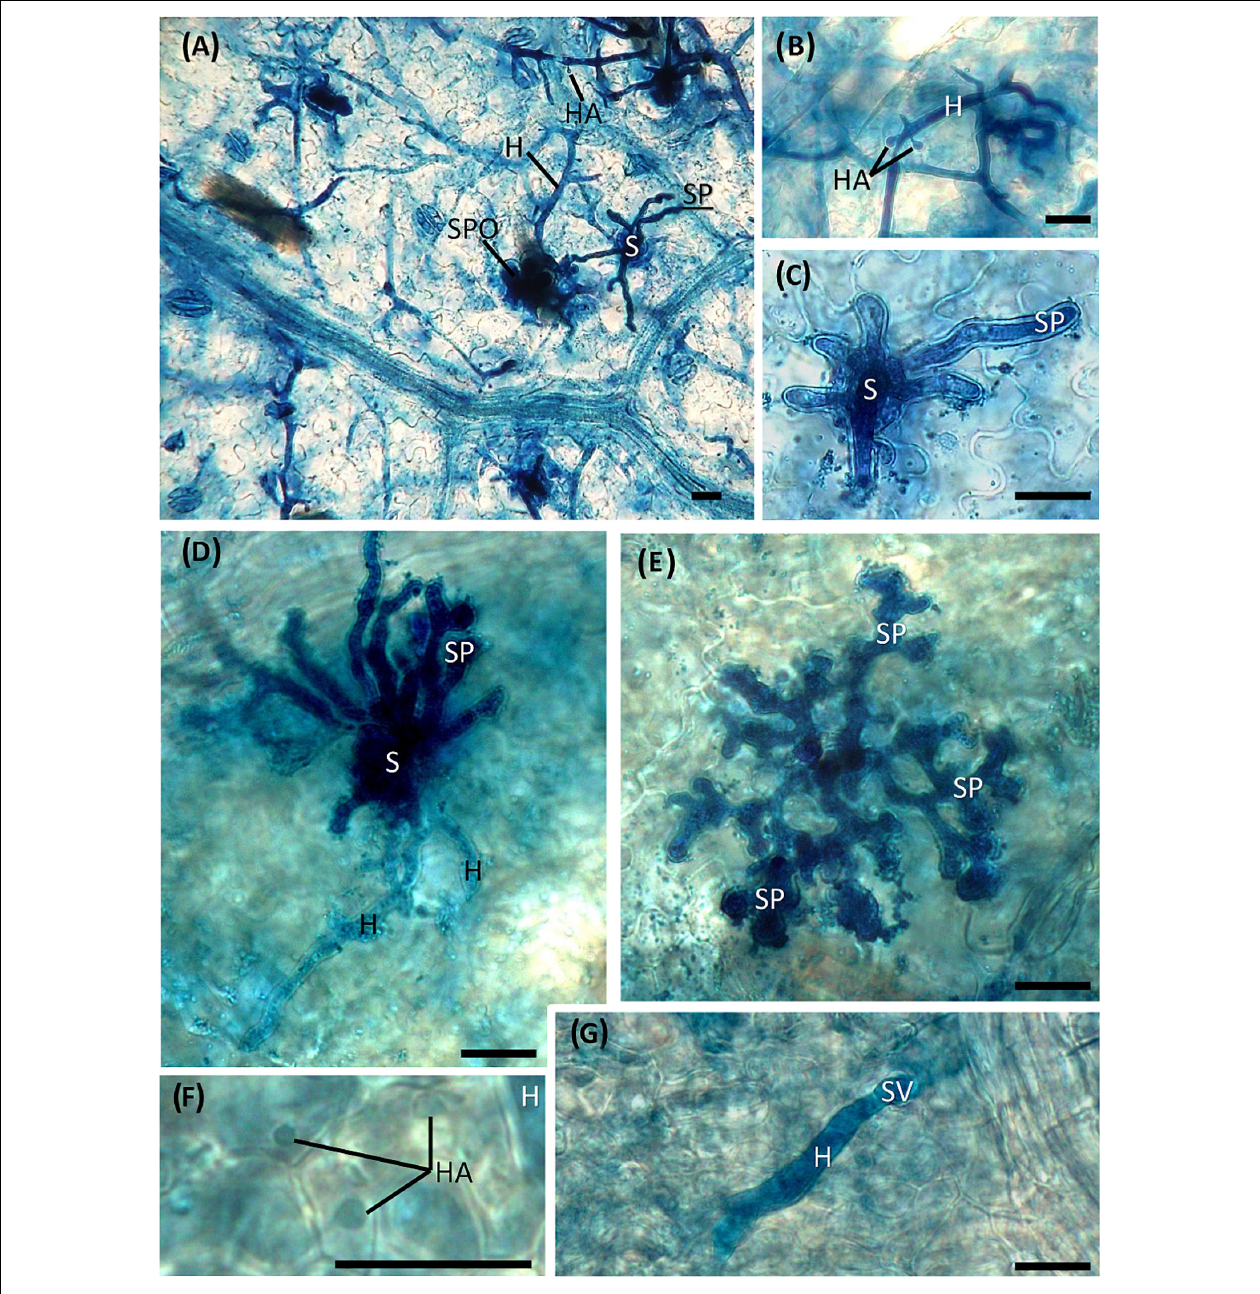
FIGURE 5 | Development of Plasmopara viticola structures inside untreated (A–C) and treated (D–G) leaf tissues inoculated at 7 dat. (A) Hyphae with haustoria developing in the mesophyll cells and sporangiophores emerging from the stomata. (B) Mycelium with haustoria; (C) detail of sporangiophores emerging from a stoma; (D) degenerating hyphae, slightly colored and vacuolized, with no visible haustoria, and hyperbranched sporangiophores emerging from the stoma; (E) short, hyperbranched and sterile sporangiophores; (F) light-colored haustoria; (G) hypha developing from the substomatal vesicle with no visible haustoria. S = stoma; H = hypha; HA = haustorium; SP = sporangiophore; SPO = sporangium; SV = substomatal vesicle. Scale bar, 20 µ